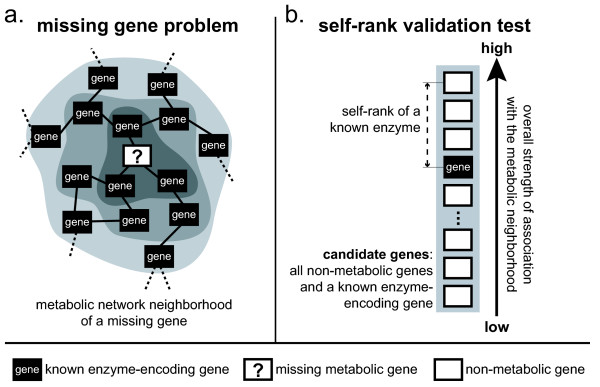
a. Illustration of the missing gene problem. Metabolic network neighborhood of a missing metabolic enzyme is shown. The neighborhood comprises layers with increasing radii (3 layers shown, indicated by shading). Majority of the enzyme-encoding genes in the neighborhood are known. b. Illustration of the self-rank validation test. Ability to predict known enzyme-encoding genes is tested by measuring its self-rank - the rank of a true enzyme-encoding gene in the candidate set. The candidates are ordered according to overall strength of their functional association with the metabolic network neighborhood of the enzyme. The overall association strength is a combination of layer association scores that measure strength of functional association of the candidate gene with known enzyme-encoding genes in a single layer of the metabolic neighborhood (3 layers, as illustrated in a.). The candidate set contains all genes that are not already part of the metabolic network.